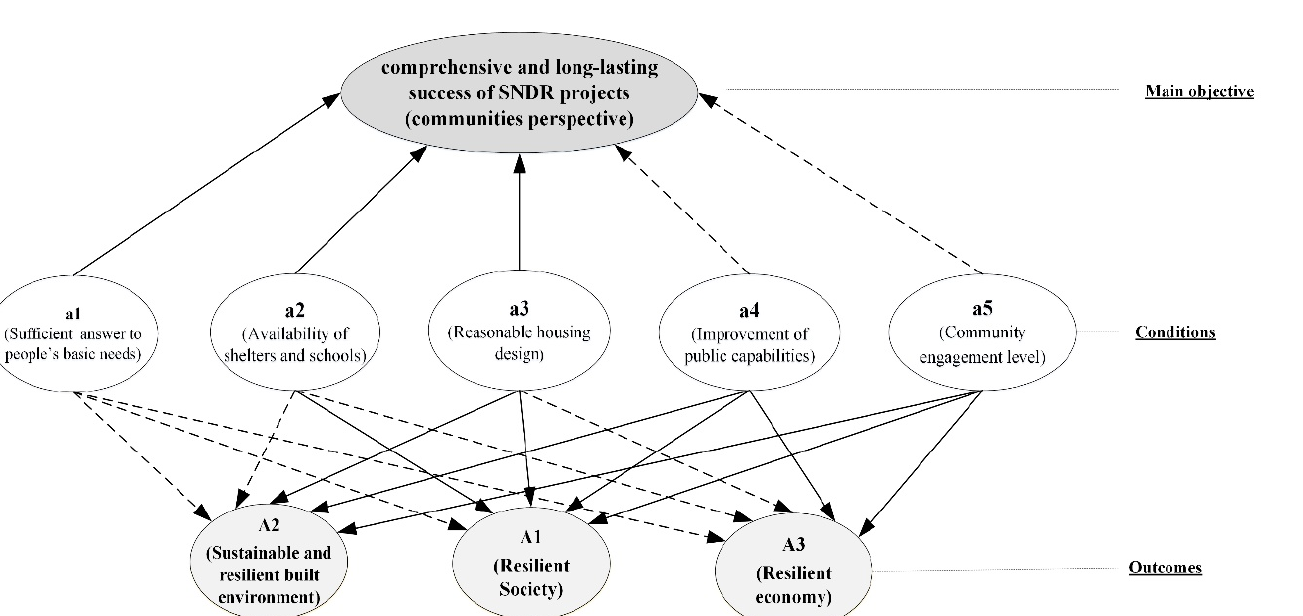
Table 2. Hypothesized causal conditions that influence the success dimensions of SNDR projects based on the community perspective.